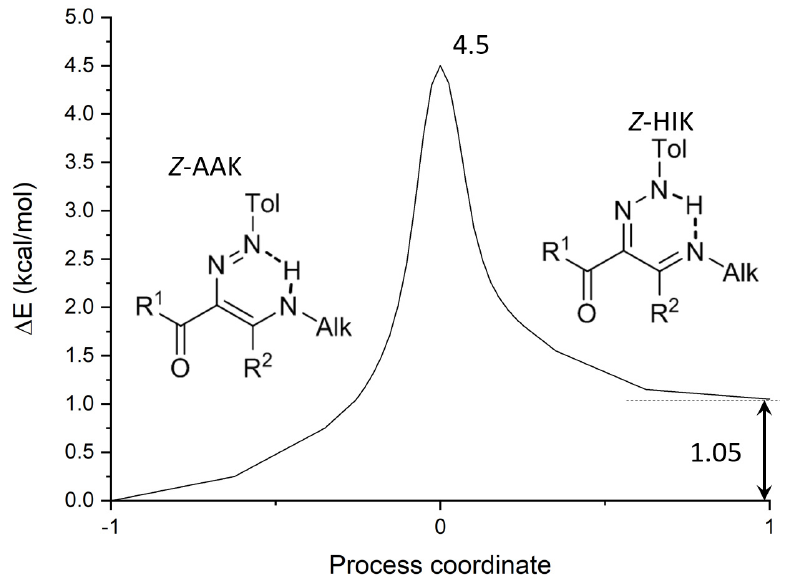
Figure 2. Energy profile of proton transfer between N2 and N3 atoms (according to Figure 1 labeling), transforming Z -AAK into the Z -HIK tautomer of compound 8a (R 1 = CF 3 , R 2 = Me).